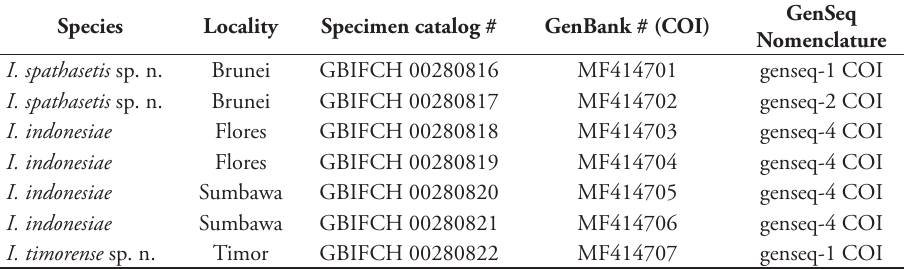
Table 1. Sequenced